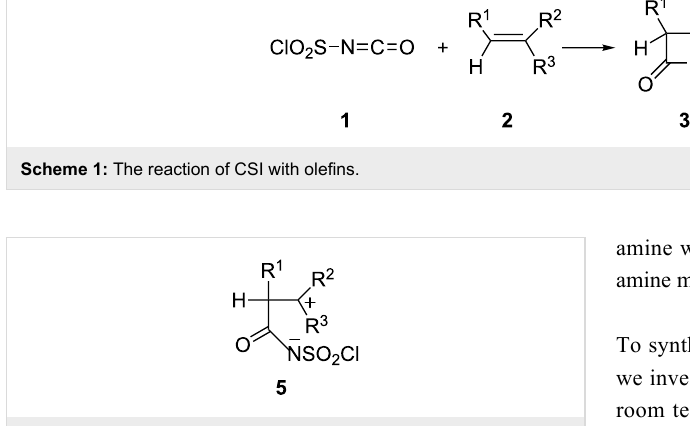
Figure 1: The dipolar intermediate formed in the reaction of CSI with